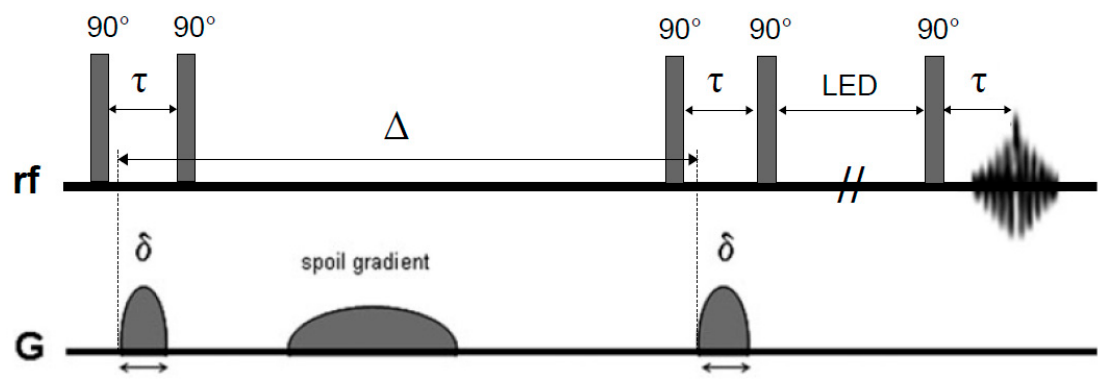
Figure 2. Pulsed field gradient Stimulated echo with LED for suppression of eddy currents before echo acquisition. Spoil gradient during diffusion time is used to remove spin echo forming after the second radio frequency (r.f.) pulse.